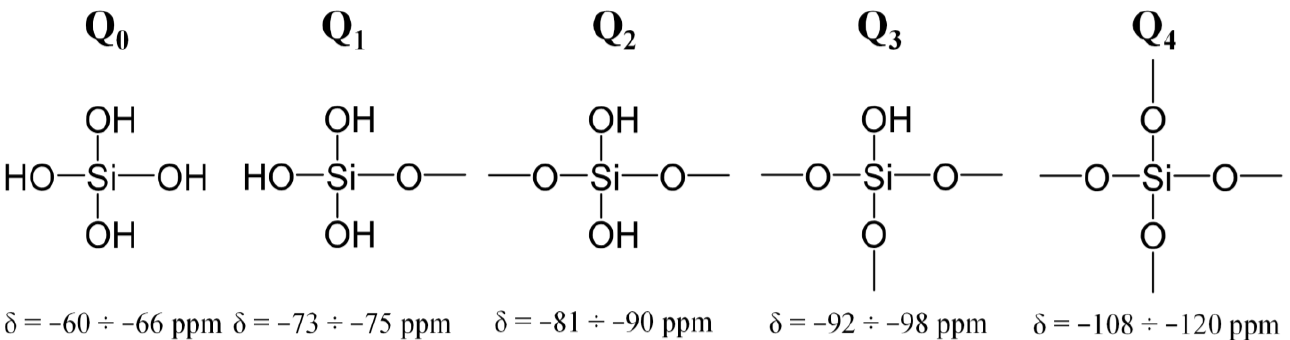
Figure 2. A stereochemical depiction of the Qn silica structural